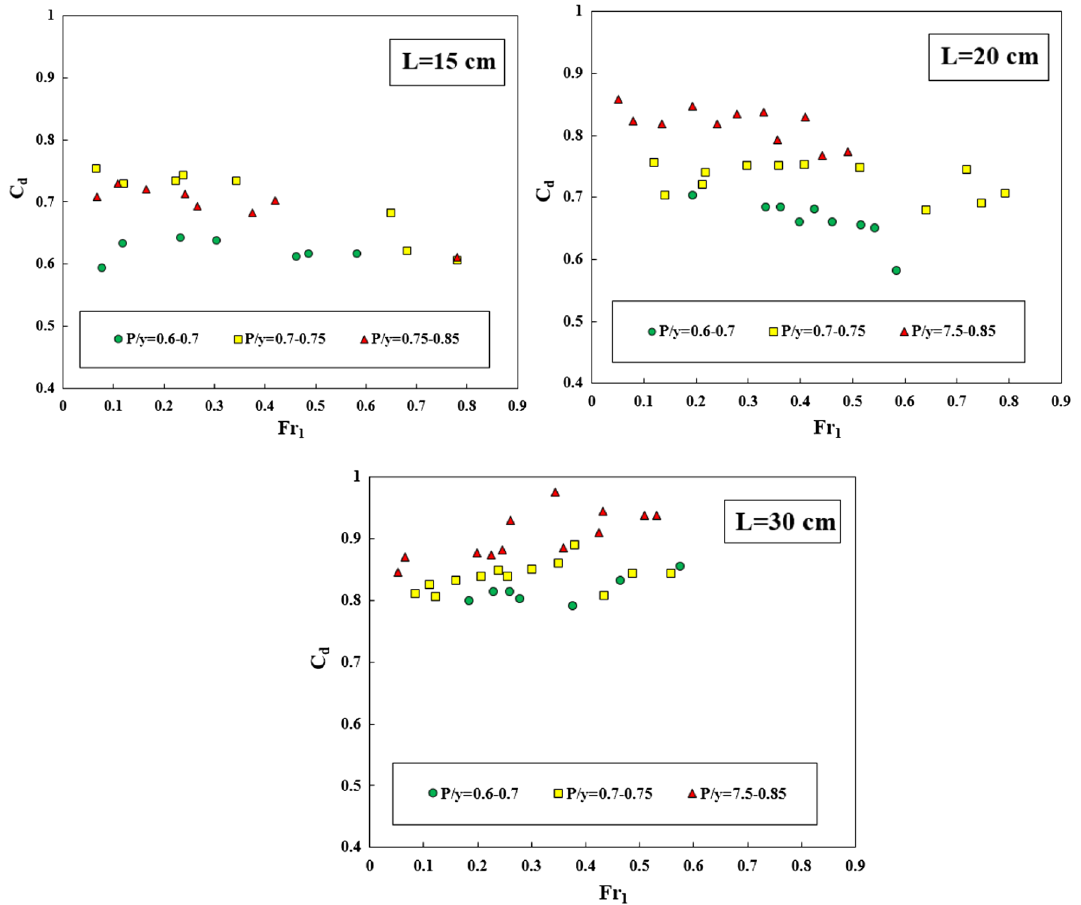
Fig. 8 Variations in C d (discharge coefficient) with upstream Froude number (Fr 1 ) ( L = 15, 20 and 30 cm)